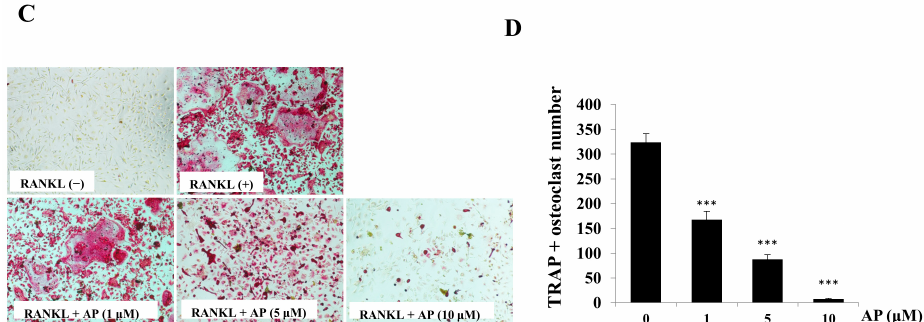
Figure 2. Effect of andrographolide on RANKL-induced osteoclast formation. BMMs were cultured in